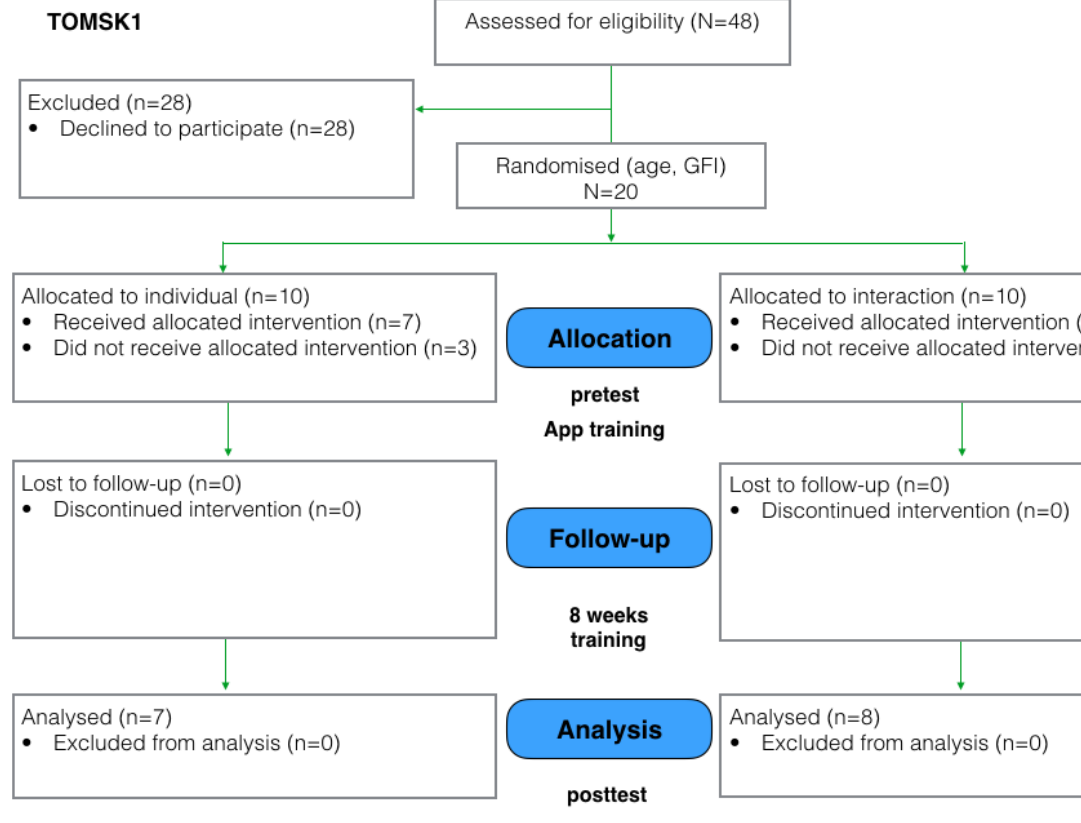
Figure 3. Study flowchart for Tomsk2 (April 2016-June